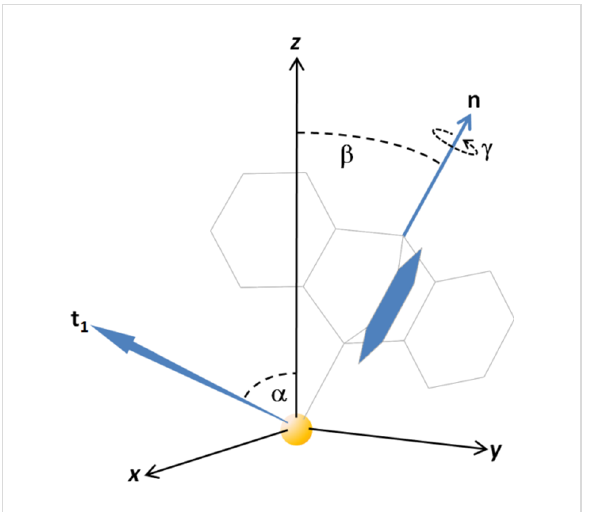
Figure 6: Illustration of relevant angles in a triptycene-based molecule anchored on a gold surface. The chalcogen atom is located in the origin of the coordinate system, the z -axis represents the substrate surface normal. The main axis n of the molecule is tilted against the surface normal (identical to the z -axis) by the angle β . The transition dipole moment t 1 related to an example aromatic ring (highlighted in blue) is tilted against the surface normal by the angle α . The rotation of the molecule about the main axis is given by γ . Further details can be found in the Supporting Information File 1.